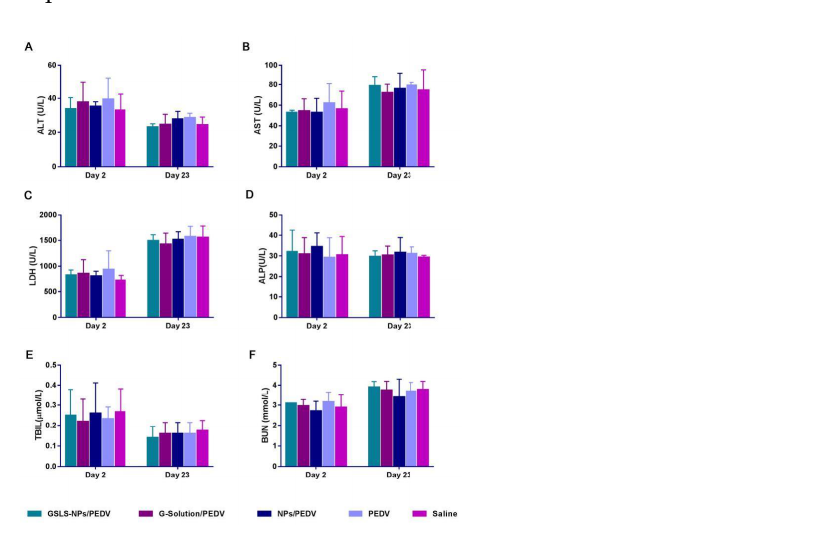
Figure 8. Serum levels of alanine aminotransferase (ALT), aspartate aminotransferase (AST), lactate dehydrogenase (LDH), alkaline phosphatase (ALP), total bilirubin (TBIL) and blood urea nitrogen (BUN). Mice (n = 6) were gavaged and immunized as described above, and serum was collected on days 2 and 23. Data are presented as the mean ± SD. Statistical differences were determined by an unpaired Student’s t test.